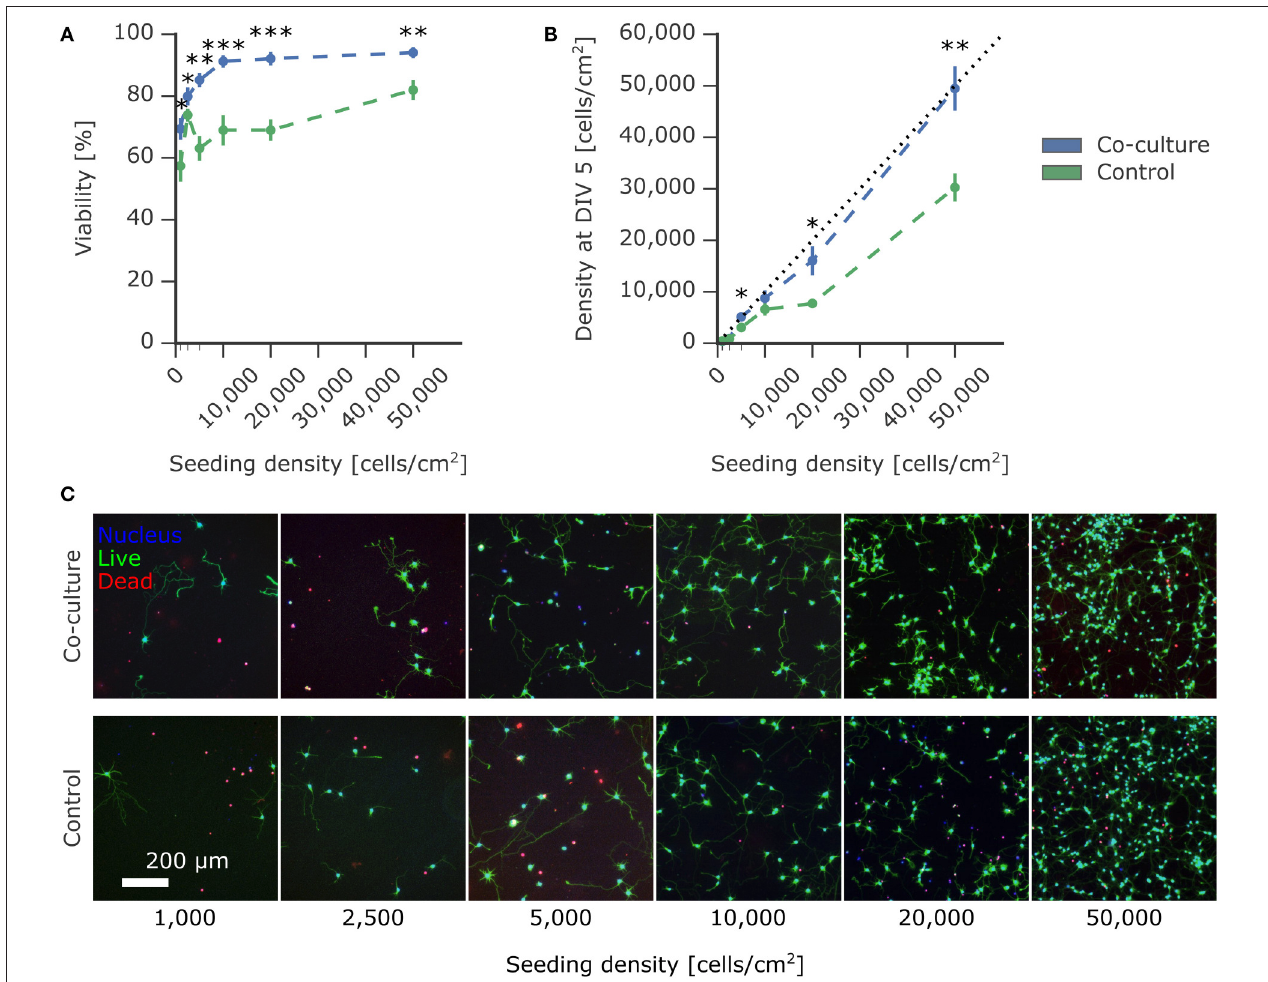
FIGURE 3 | Effect of astrocyte co-culture on the viability of low-density neuron cultures. Primary rat cortical neurons were seeded on PDL-coated coverslips at densities ranging from 1,000 to 50,000 cells/cm 2 with paper-based astrocyte co-culture and without co-culture as a control. The viability was measured using a live/dead viability assay at 5 DIV. (A) The viability of the experimental neuron culture supported by the co-culture was significantly improved compared to the control without co-culture. (B) The density of live experimental neurons on the coverslip was calculated using the live-dead assay images and compared to the seeding density. The co-culture condition showed minimal loss of cells compared to the control condition. (C) Representative images of the experimental neuron culture with and without co-culture at different seeding densities. Plotted values are mean ± standard error and significance was tested using Mann-Whitney U test with significance levels: * if p < 0.05; ** if p < 0.005; *** if p <